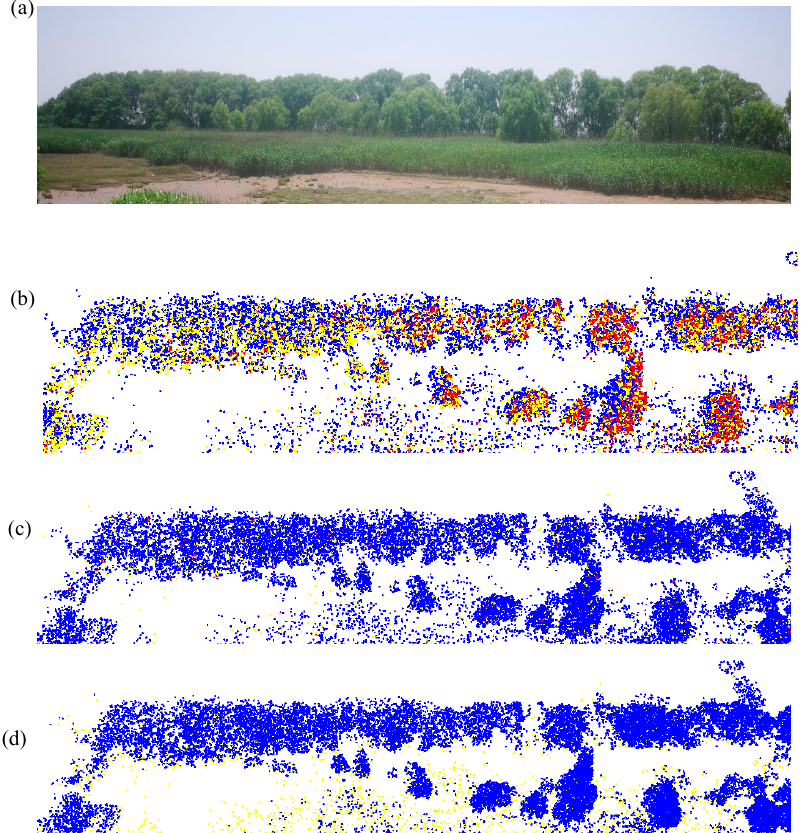
Figure 13. Comparison of ( a ) an RGB photograph on site and the corresponding region in the classification results by ( b ) original intensity data, ( c ) corrected intensity data by the improved method, and ( d ) manual and software (LiDAR360) combination. The yellow, blue, and red points represent muddy flat, vegetation and cement road, respectively.